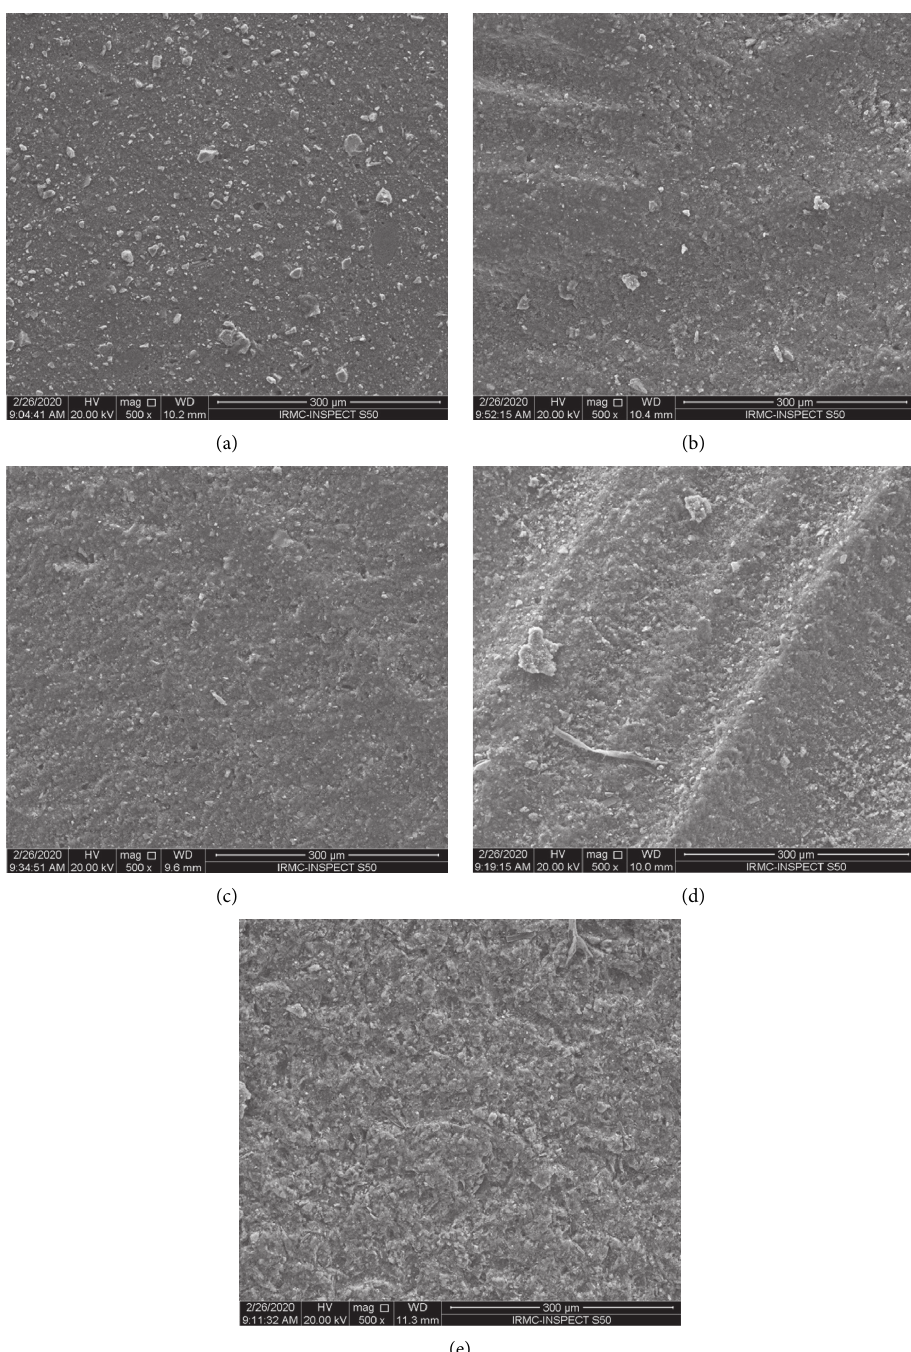
Figure 2: (a), (b), (c), (d), (e) SEM representative images for surface treatment